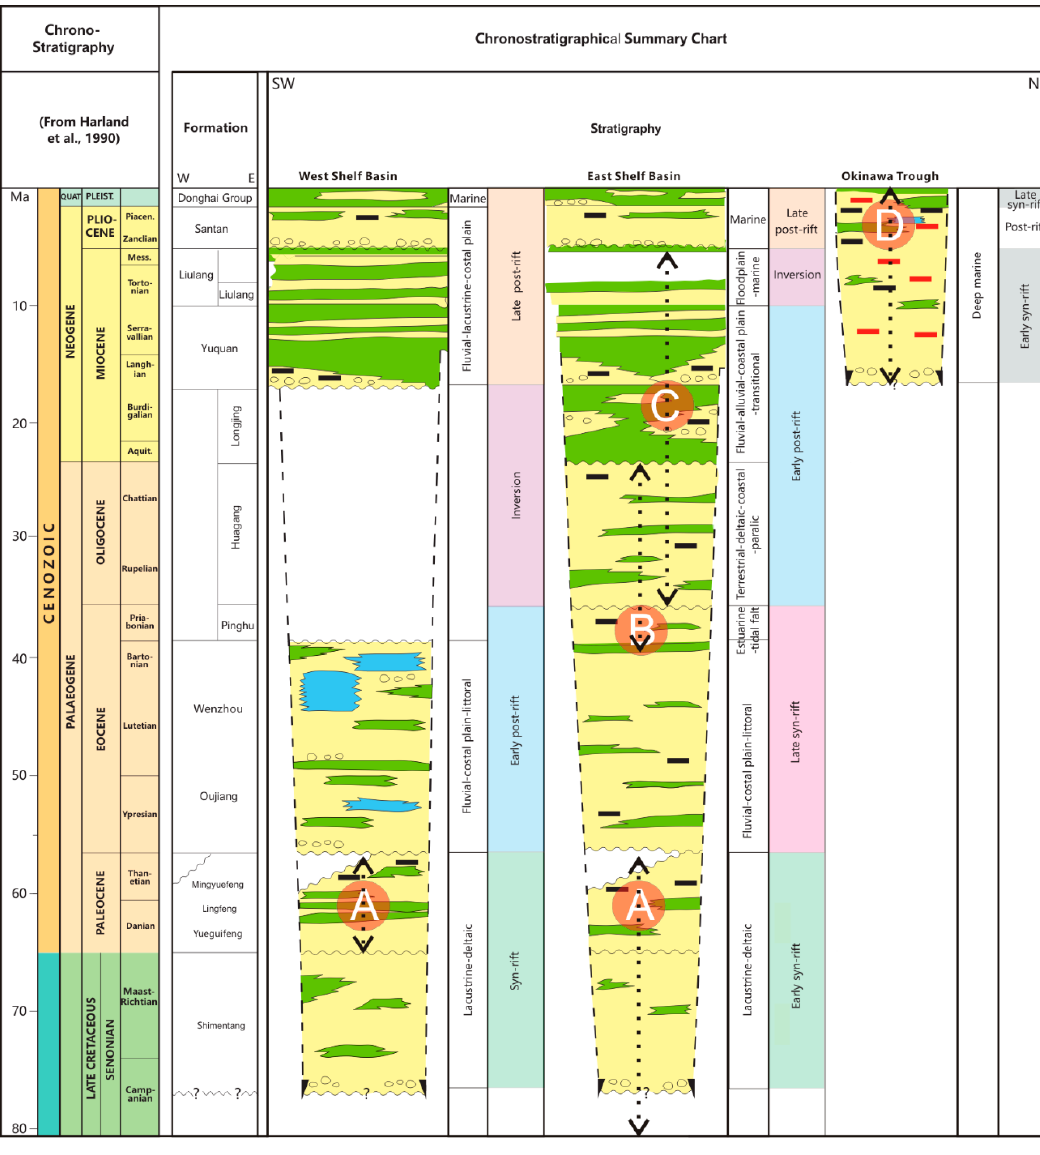
Figure 5. Chrono-stratigraphy of the West Shelf Basin (i.e., Lishui Sub-basin), East Shelf Basin (i.e., Xihu Sub-basin), and the Okinawa Trough of the East China Sea Basin, showing lithofacies, (sub-)basin cycles, and identified petroleum system types (PSTs) and their play levels. A = PST A; B = PST B; C = PST C; D = PST D (black dashed lines show the extent of each PST). In the stratigraphic column, green represents claystone, yellow indicates sandstone, blue stands for carbonate, black represents coal, and red indicates volcanics. Time scale and lithology are based on data and analyses in References [1,24,27,34–36,42,43].